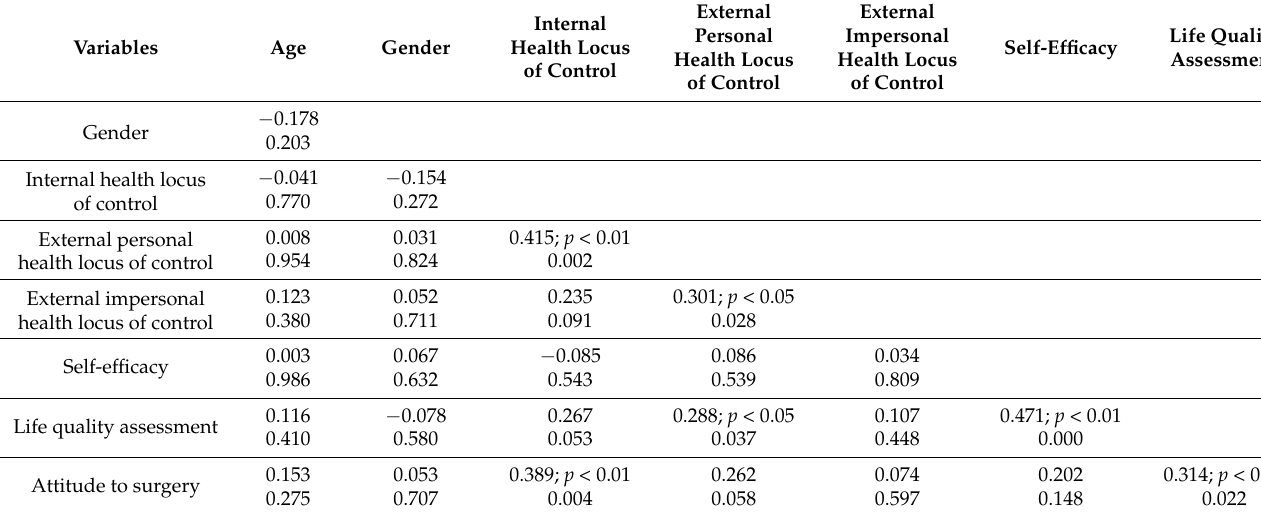
Table 1. Correlations between attitude to surgery, age, gender, and the selected constituents of personal resources in ICAS patients.